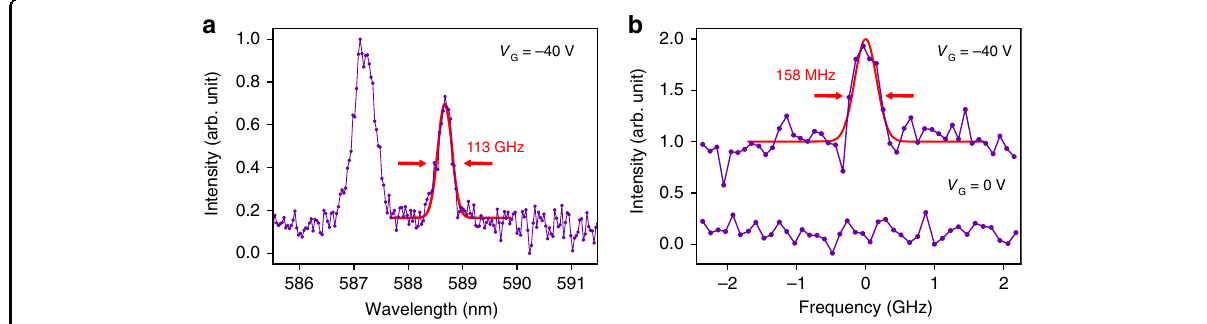
Fig. 5 Coherent excitation of quantum emitters in hBN. a Emission spectrum of a single emitter with a ZPL at ~588.5 nm, recorded under non- resonant 532 nm excitation. b Resonant excitation of the same emitter, resulting in a nearly-coherent photon source with a linewidth of ~158 MHz. Both measurements were done using a bias voltage, V G = – 40